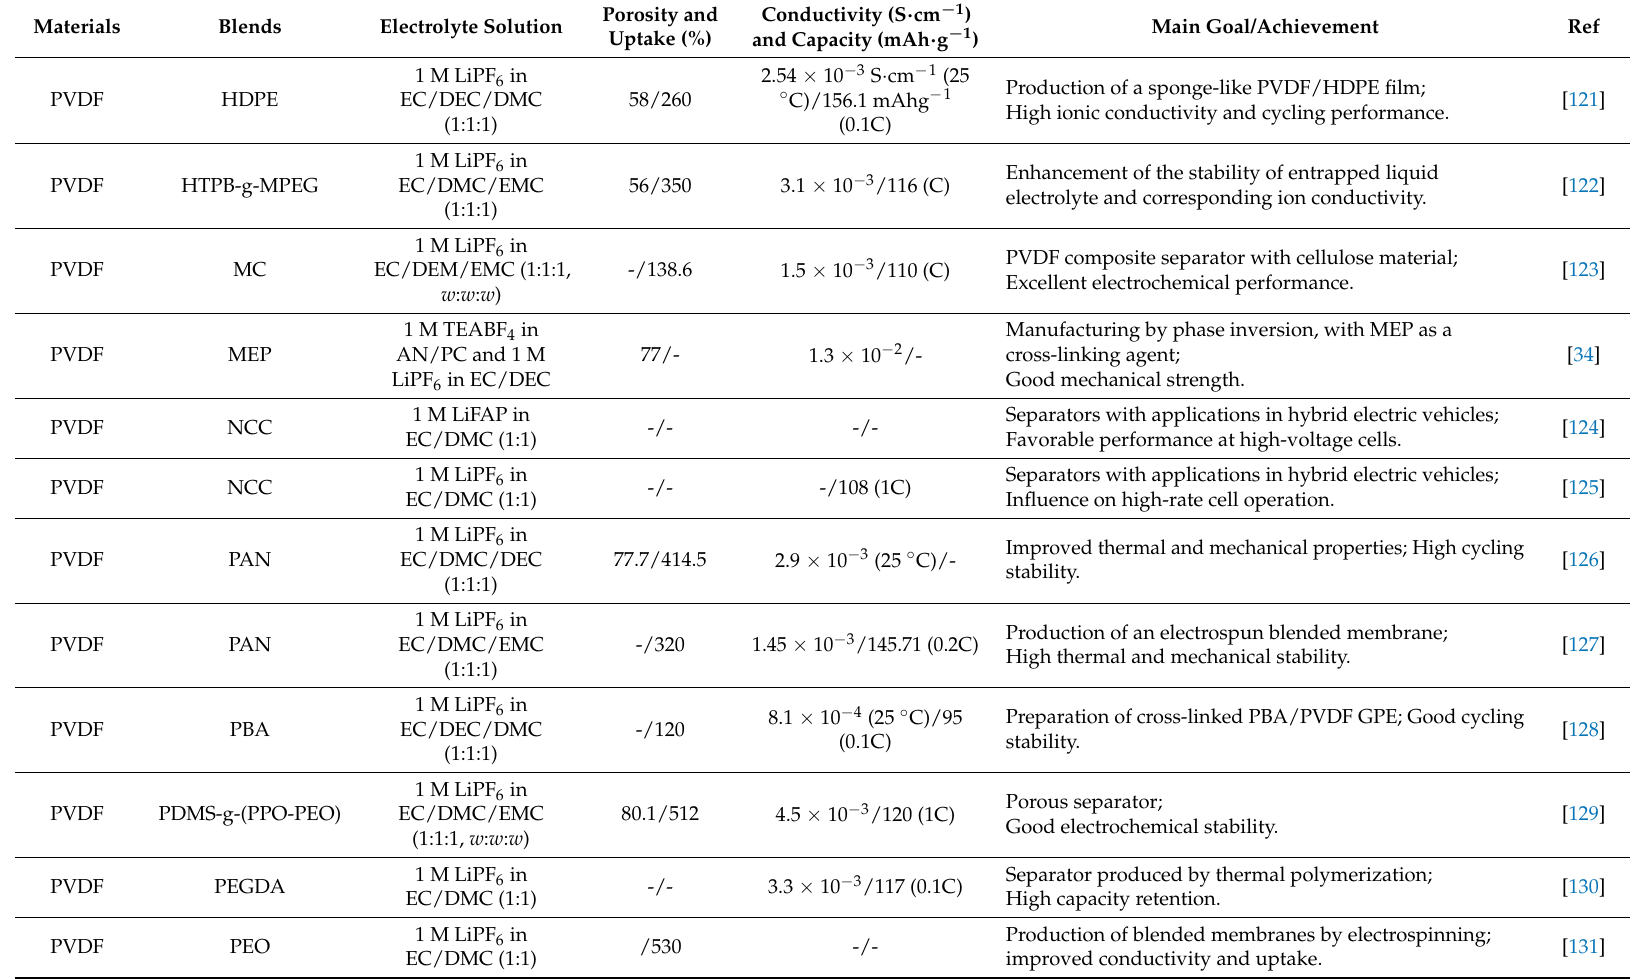
Table 6. Polymer blends based on PVDF and co-polymers with main properties, goal, and